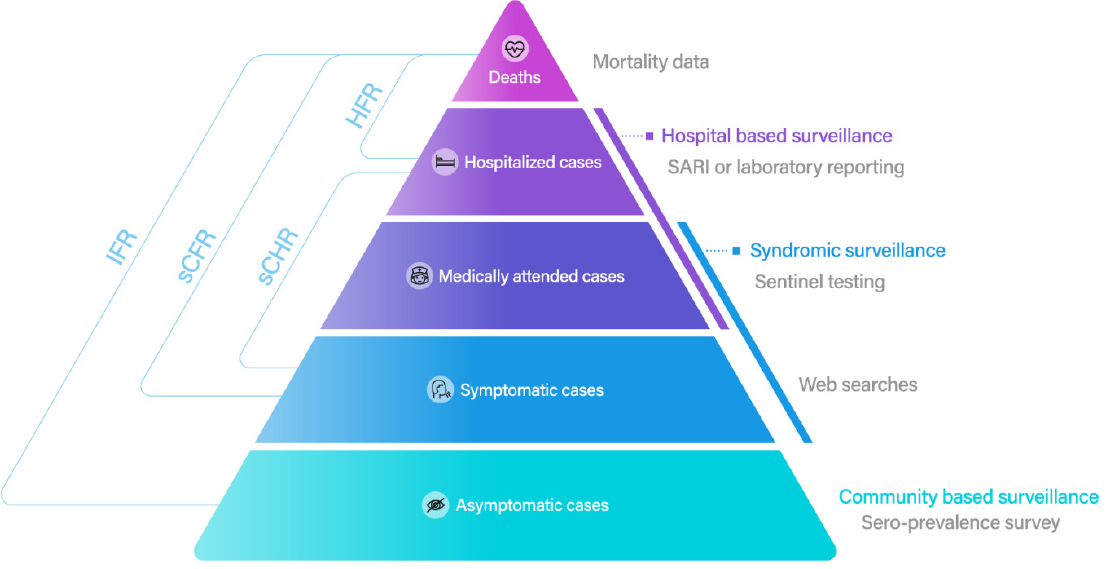
Figure 1. The burden pyramid of infectious disease and epidemiological severity parameters. The clinical spectrum of infectious diseases and the possible surveillance system at each level. Note: SARI = severe acute respiratory infection, IFR = infection fatality rate, sCFR = symptomatic cases fatality rate, sCHR = symptomatic hospitalization rate, HFR = hospitalization fatality rate.